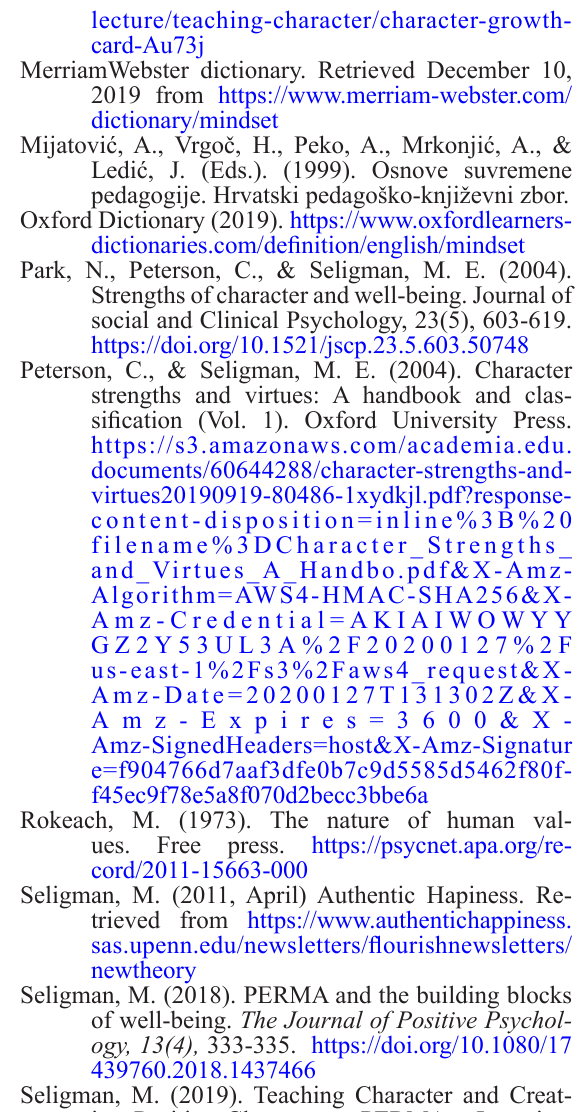
Algorithm=AWS4-HMAC-SHA256&X- A m z - C r e d e n t i a l = A K I A I W O W Y